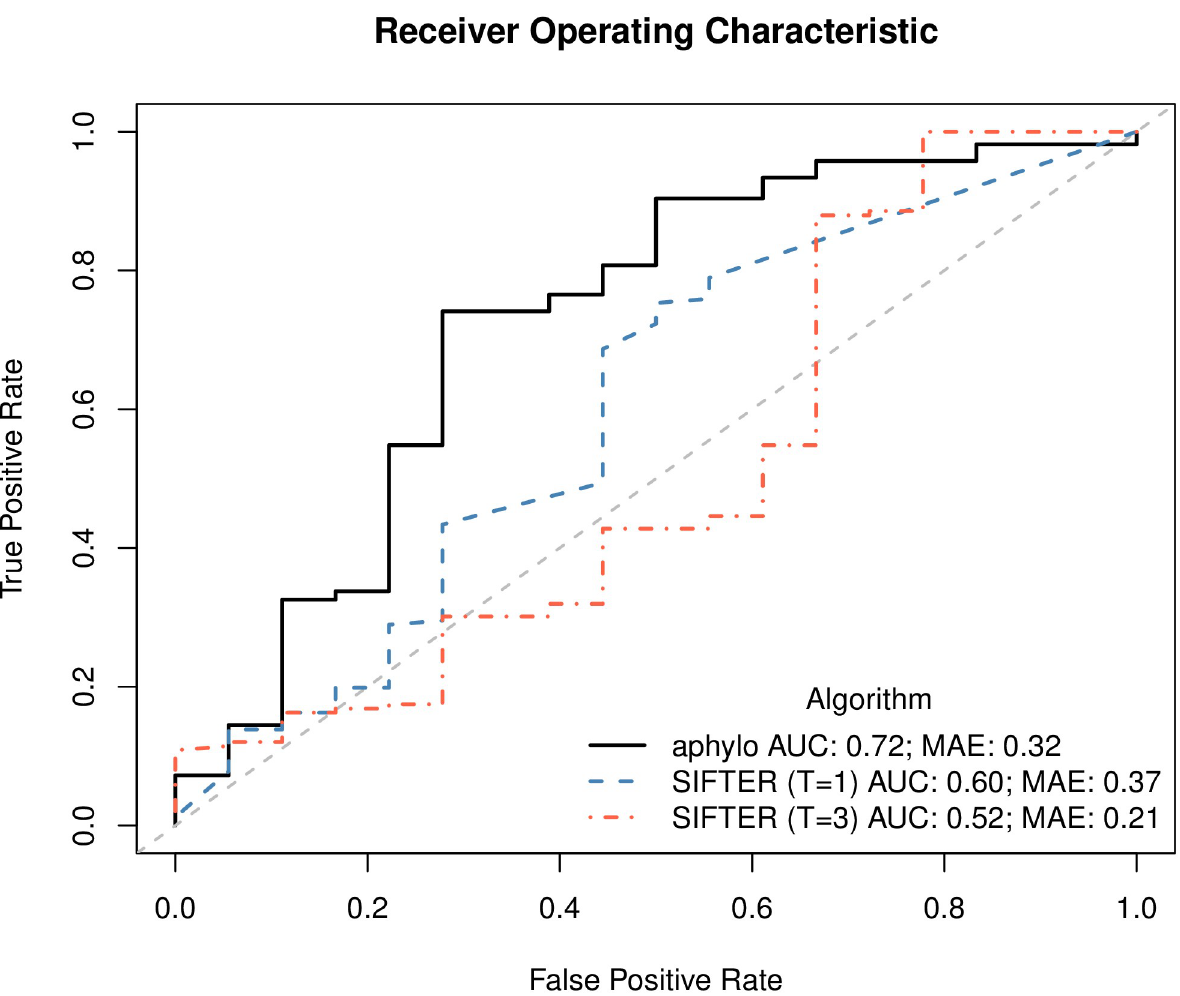
Fig 8. ROC curve for aphylo and SIFTER predictions. This figure includes 184 annotations on 147 proteins. Of the 184 annotations, 18 were negative. The corresponding AUC for these curves are 0.72 for aphylo, and 0.60 and 0.52 for SIFTER using truncation level 1 and truncation level 3